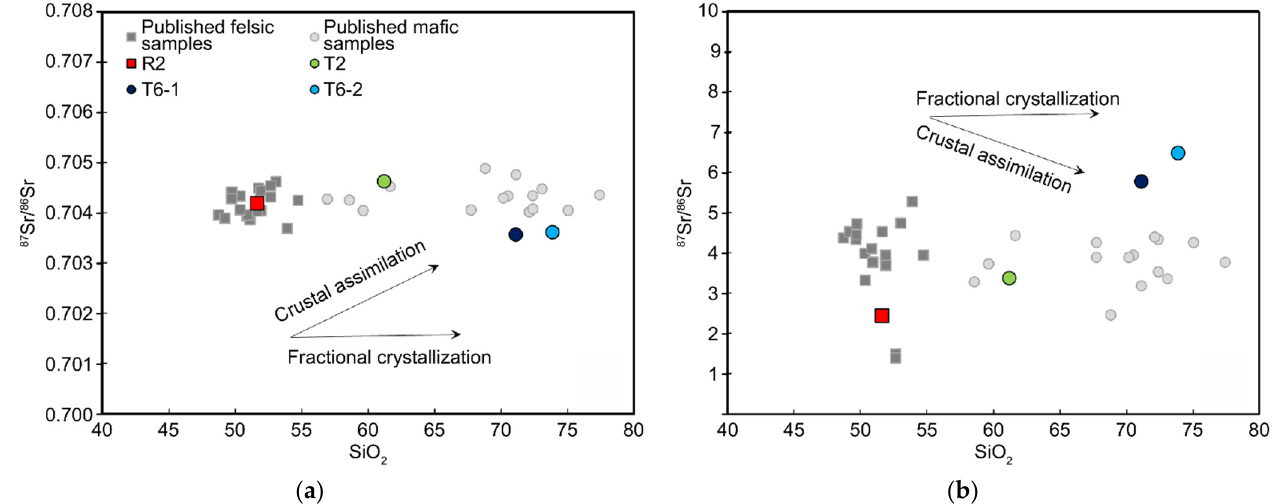
Figure 7. ( a ) SiO 2 vs. 87 Sr/ 86 Sr and ( b ) SiO 2 vs. 143 Nd/ 144 Nd plots showing that crustal assimilation slightly influenced the magmatic evolution of the MOT and SOT volcanic lavas. Data for published mafic samples are from [1,36,50,74]. Data for published felsic samples are from [1,73,74]. Data for samples T6-1, T2, and T6-2 are from this study.